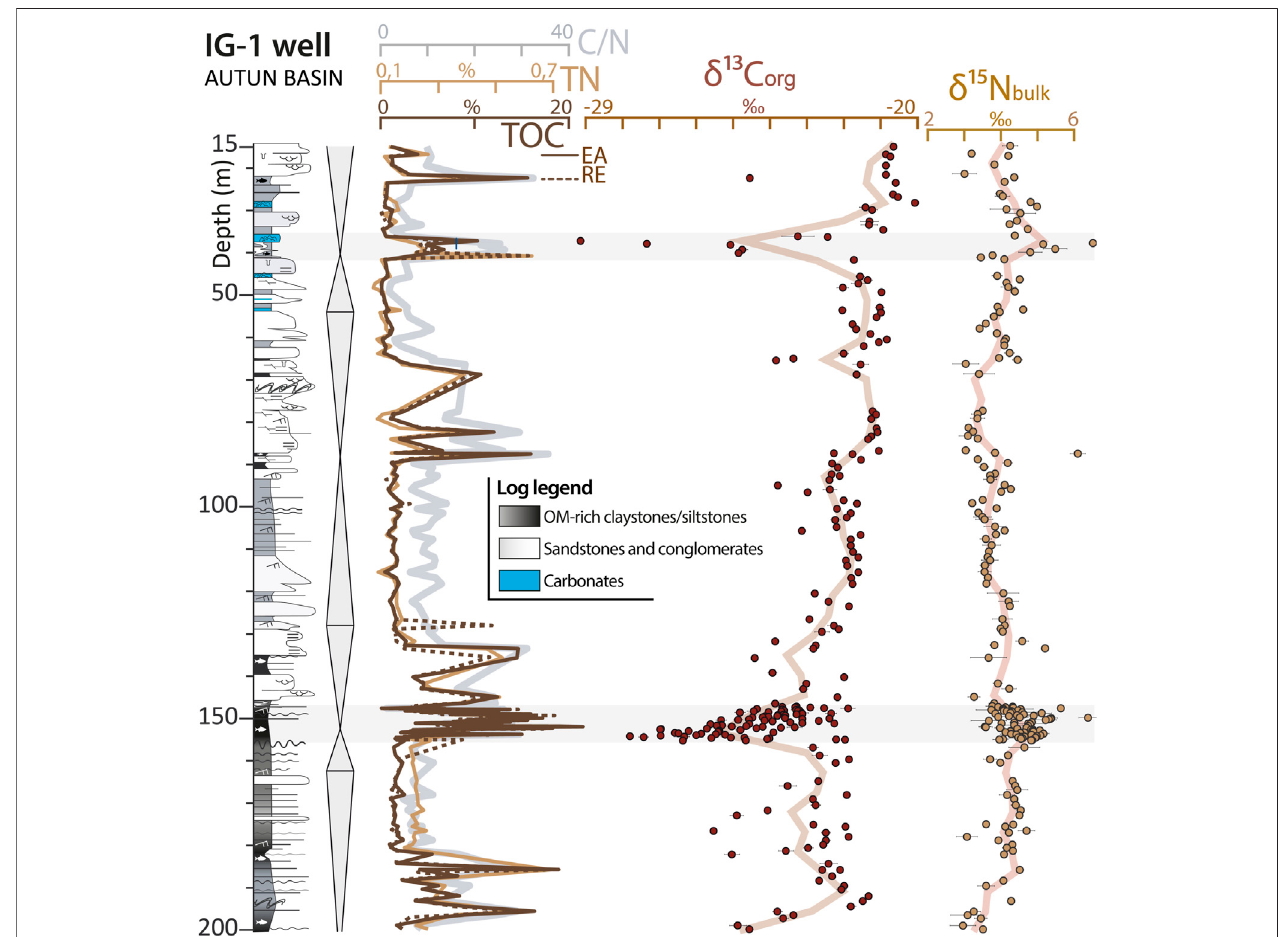
FIGURE 3 | Sedimentary section, sequence stratigraphy of the IG-1 core (Autun Basin) and organic signal evolution (total organic carbon TOC, total nitrogen TN, C/N atomic ratio, δ 13 C org and δ 15 N bulk variations). The log caption is displayed on Figure 2 . RE, Rock-Eval pyrolysis.